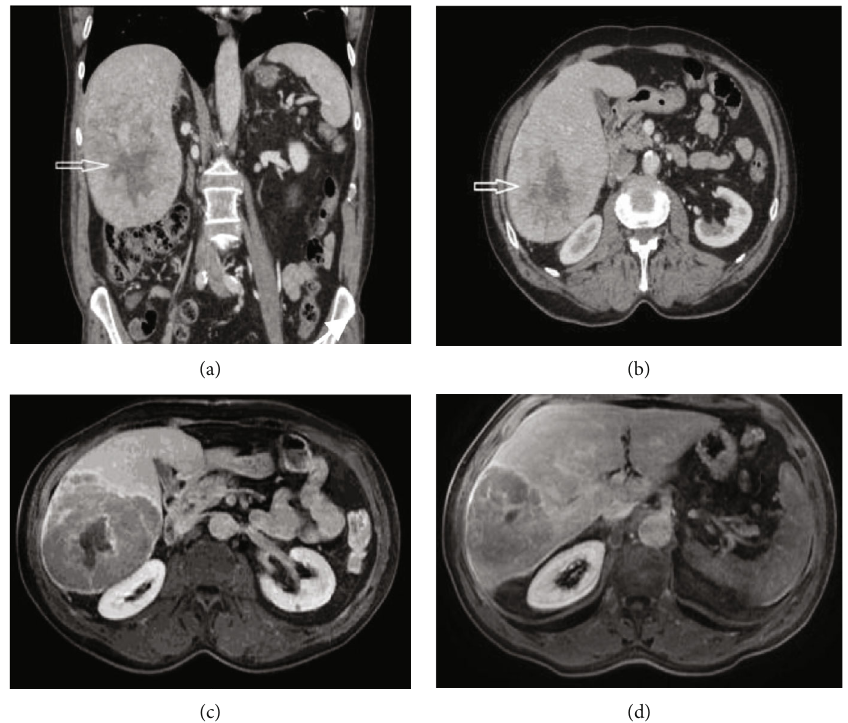
Figure 2: Coronal (a) and axial (b) CT scan images showing a large ( > 10 cm) inhomogeneously enhancing liver mass with a central scar occupying liver segments V, VI, and VII (arrow). (c, d) Axial post contrast MRI image demonstrating heterogeneously enhancing liver mass with washout and central nonenhancing component, features mostly consistent with atypical